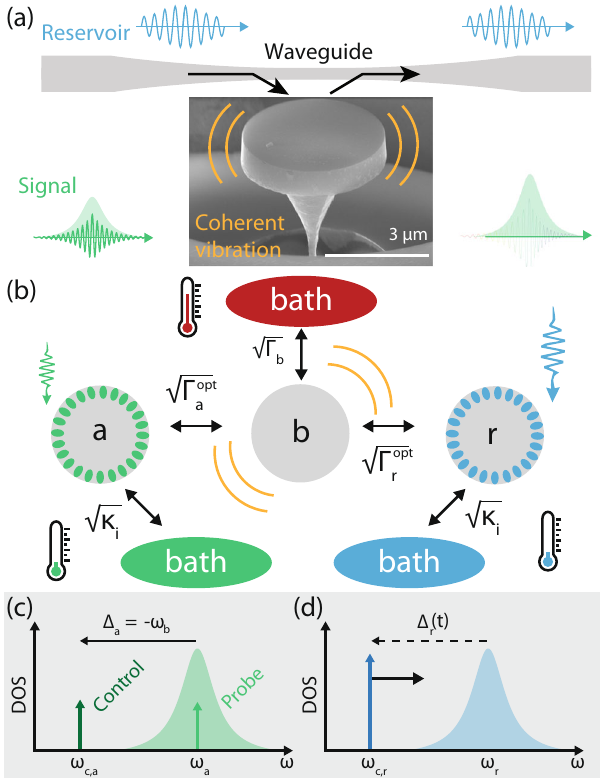
Fig. 1 Key elements of the tunable optomechanical memory. a Annotated scanning electron micrograph of the diamond microdisk optomechanical cavity. A tapered optical fi ber is utilized to couple light into two of the microdisk whispering gallery modes which in turn are coupled to mechanical vibrations of the radial breathing mode of the microdisk. b Schematic of the system under study where the mechanical mode b is coupled to the environment (red bath), an optical reservoir mode, r , and the optical mode a used for writing and reading the information, at the indicated rates. While coupling of the mechanical mode to the surrounding environment is an intrinsic property of the device and environment, the coupling to r may be manipulated through the use of a control laser. c , d Density of states (DOS) picture showing the detuning of the control and probe laser fi elds for ( c ) mode a and ( d ) mode r . Here, ω c,a and ω c,r are the frequencies of the control lasers for the signal and reservoir modes,